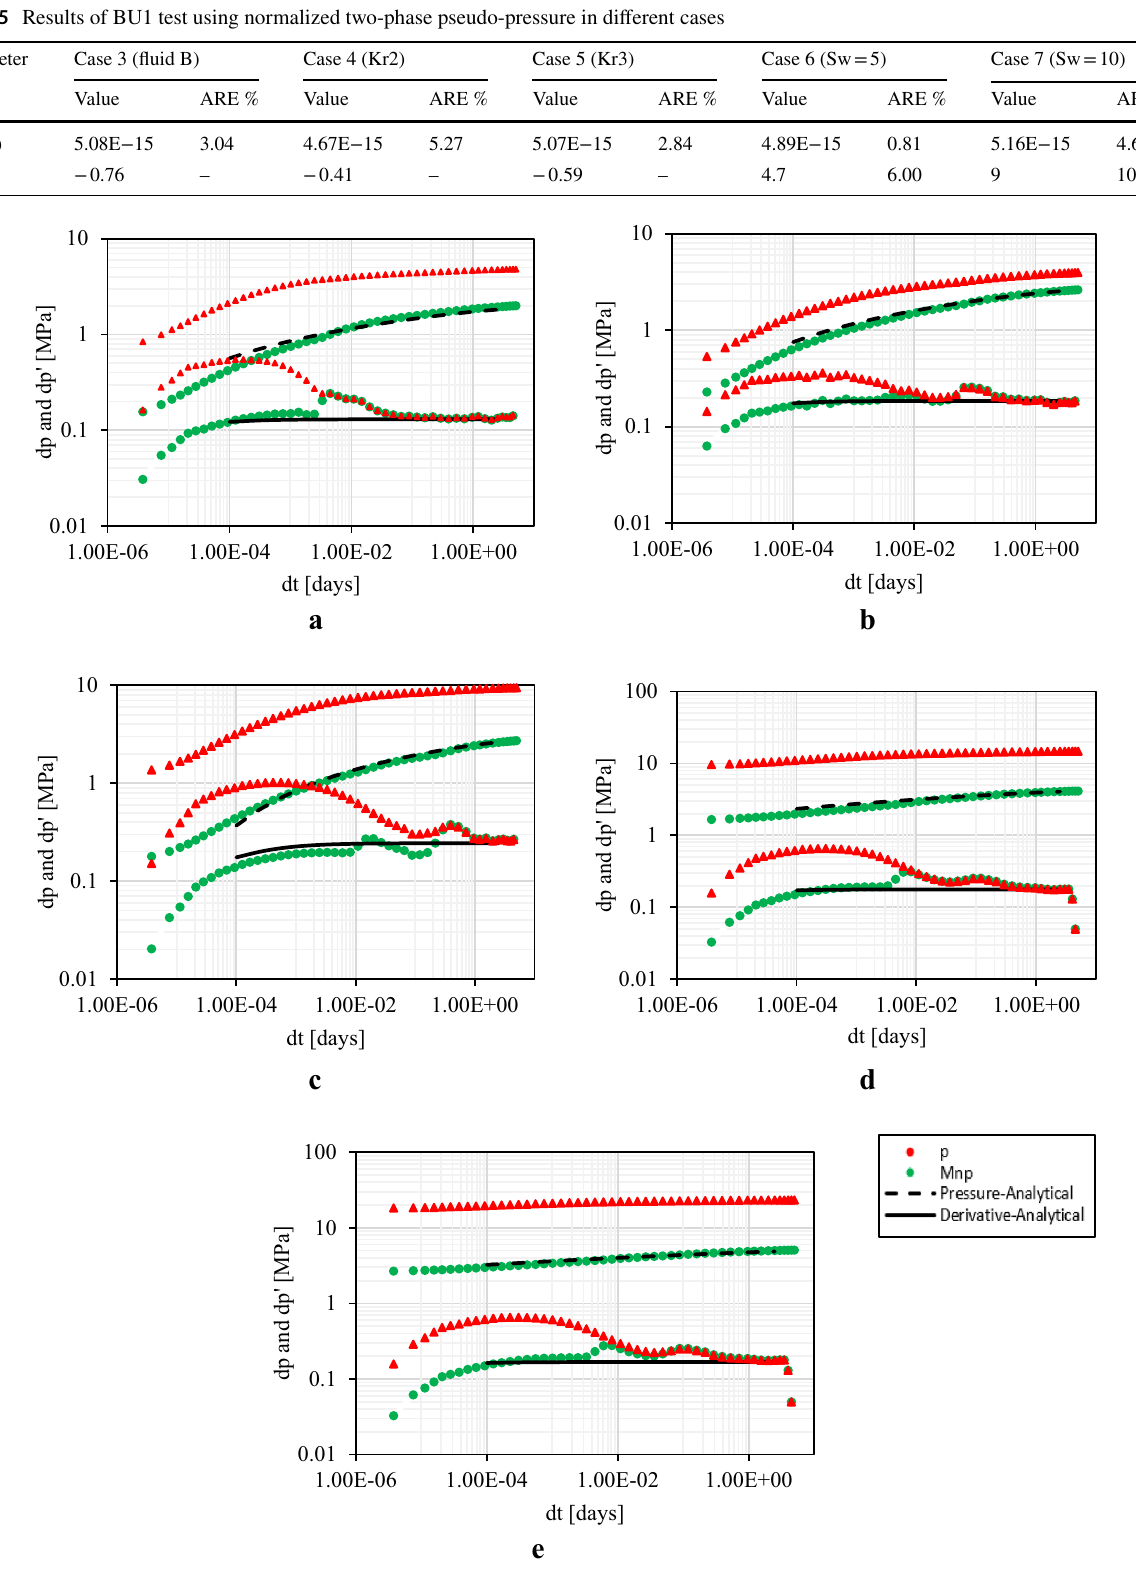
Fig. 13 Log–log pressure and derivative (pressure vs two-phase pseudo-pressure in BU1 test; a case 3 (fluid B), b case 4 (Kr2), c case 5 (Kr3), d case 6 (Sw = 5), and e case 7 (Sw =